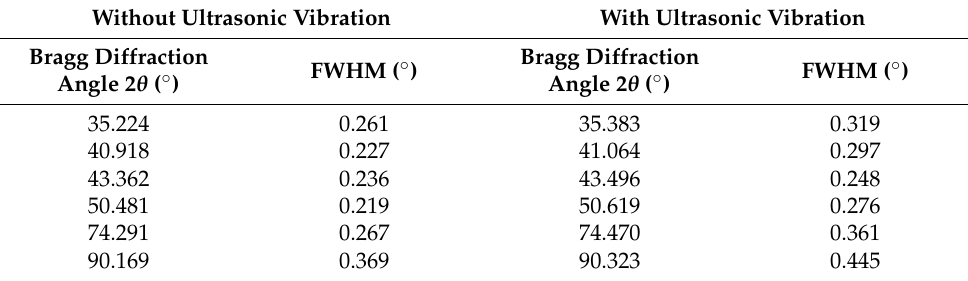
Table 2. The calculations based on the XRD results. Without Ultrasonic Vibration With Ultrasonic